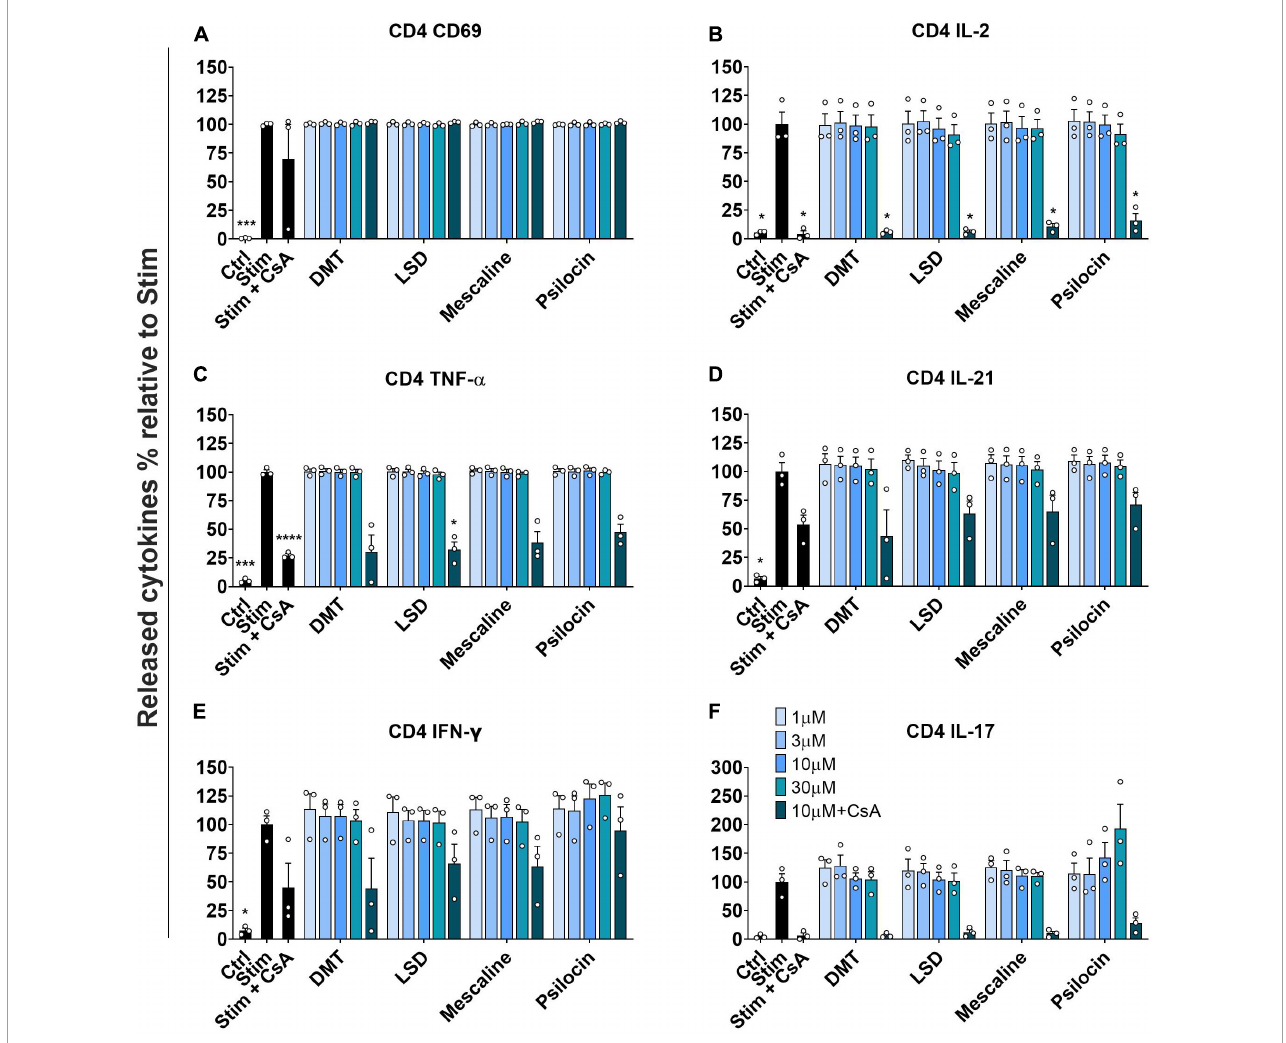
FIGURE3 Influence of classic psychedelics on (A) the activation (CD69) and function/mediator release in form of (B) IL-2 release, (C) TNF- α release, (D) IL-21 release, (E) IFN- γ release, and (F) IL-17 release of primary human CD4 + T cells. PBMCs were stimulated with anti-human CD3 and anti-human CD28 mAb (Stim) and incubated in the presence of medium alone (Neg Ctrl) and psychedelic compounds for 48 h. PBMCs were re-stimulated with PMA and ionomycin for 4 h. Cyclosporine A (CsA) served as a control substance for cytokine release inhibition. Data are the mean ± SEM from three independent experiments. Data were analyzed by one-way ANOVA followed by Dunnett’s T3 multiple comparison test (**** P < 0.0001, *** P < 0.001, * P < 0.05 when compared to stimulated cells without drug